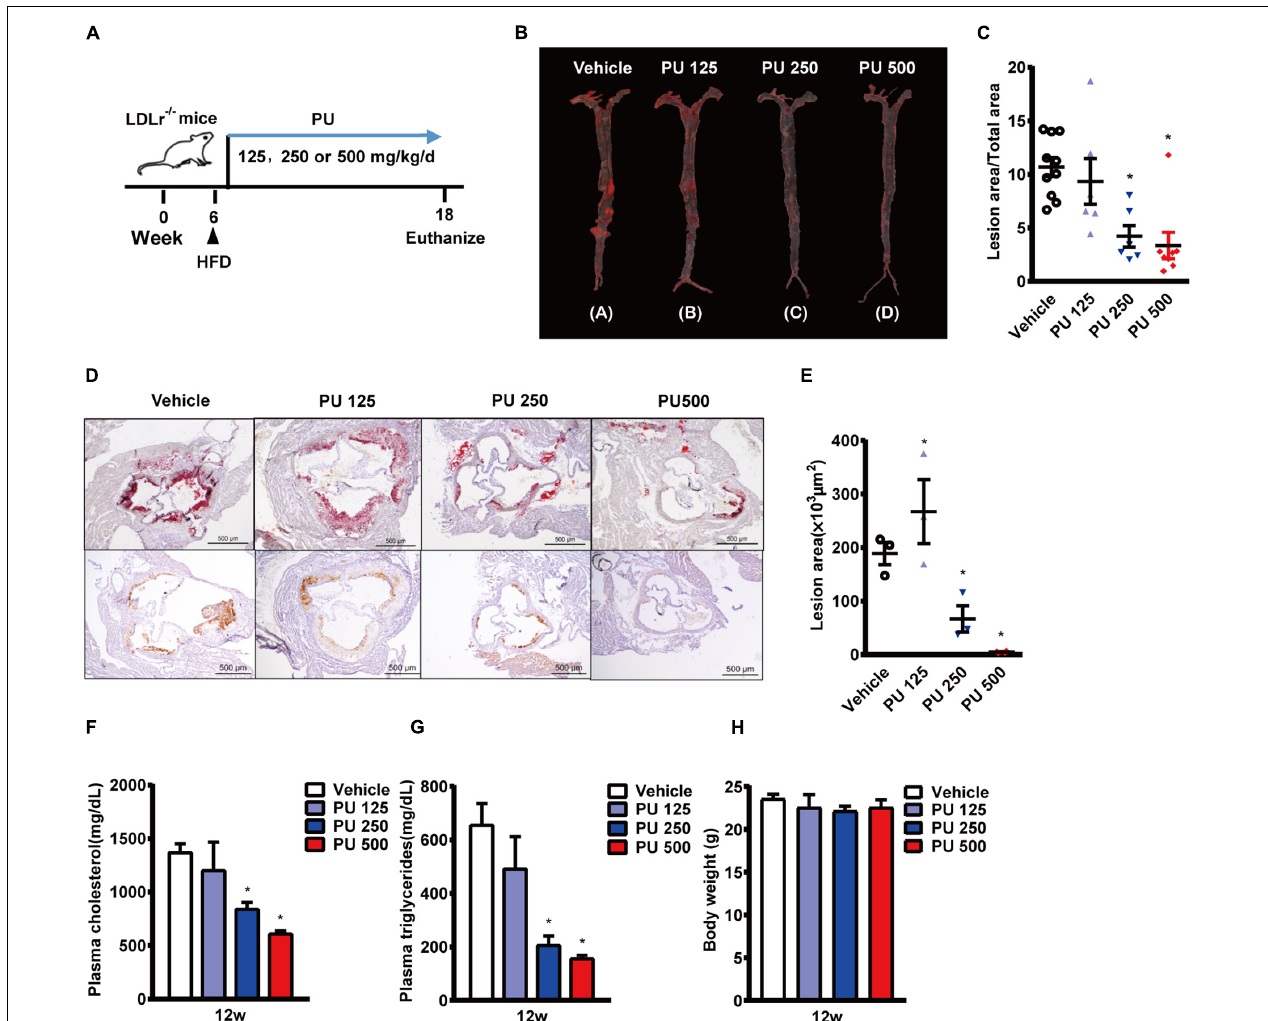
FIGURE 2 | Anti-atherogenic effects of PU on LDLR − / − mice fed with HFD. (A) Schematic diagram of the experiments; (B,C) representative images of Oil Red O staining of mouse aortas (B) and quantitative results (C) ; (D,E) representative images of Oil red O staining of mouse aortic outflow tract (upper) and immunostaining of Mac-2 (bottom); (F,G) . plasma TC (F) and TG (G) levels after feeding HFD for 12 weeks; (H) Body weights of the mice. PU 125, PU 250, and PU 500 represent PU at the doses of 125, 250, and 500 mg/kg/day, respectively, including n = 5–10 biological replicates. * P < 0.05 vs. Vehicle.